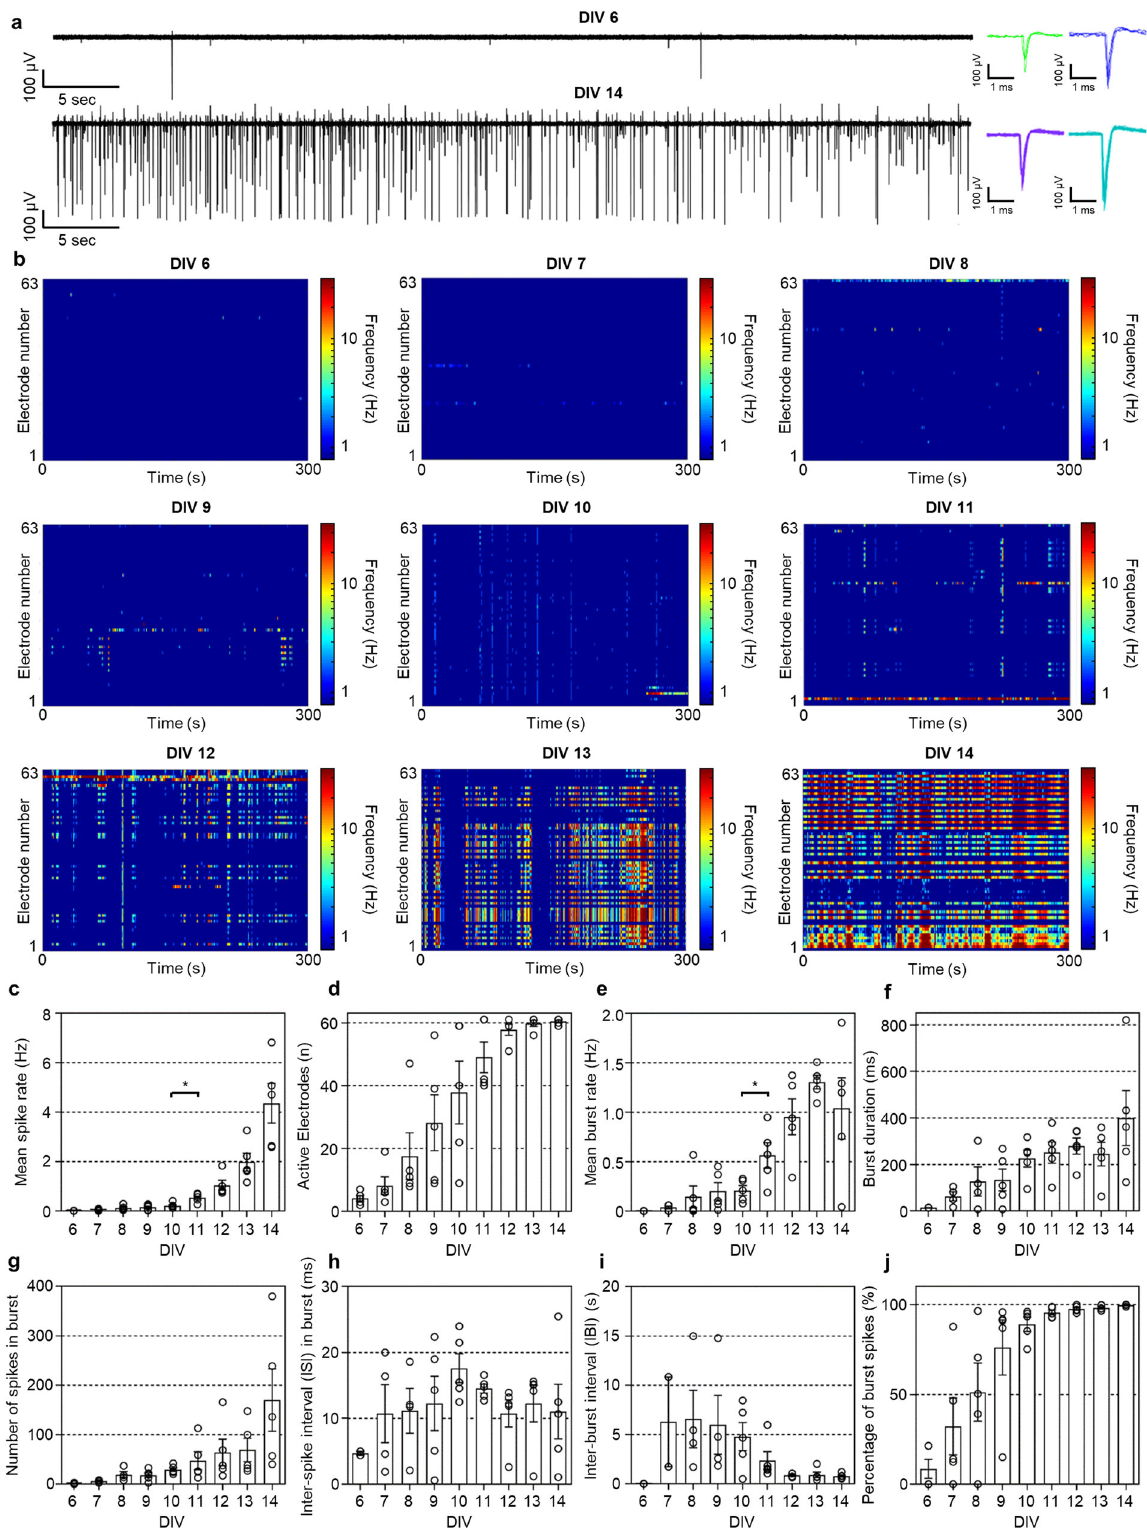
Dynamics of neural network with optical and chemical stimuli . For the precise investigation of the synaptic connectivity before and after the formation of the functional neural network in 3D, we utilized optogenetics as a verifying tool capable of cell type- speci fi c stimulations 38 . After expressing a light-sensitive ion channel, i.e., channelrhodopsin-2 (ChR2), in the primary rat